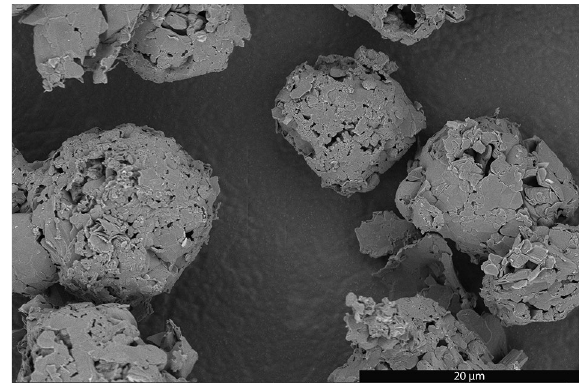
Figure 7. SEM image of BCG made from cellulose spheroid